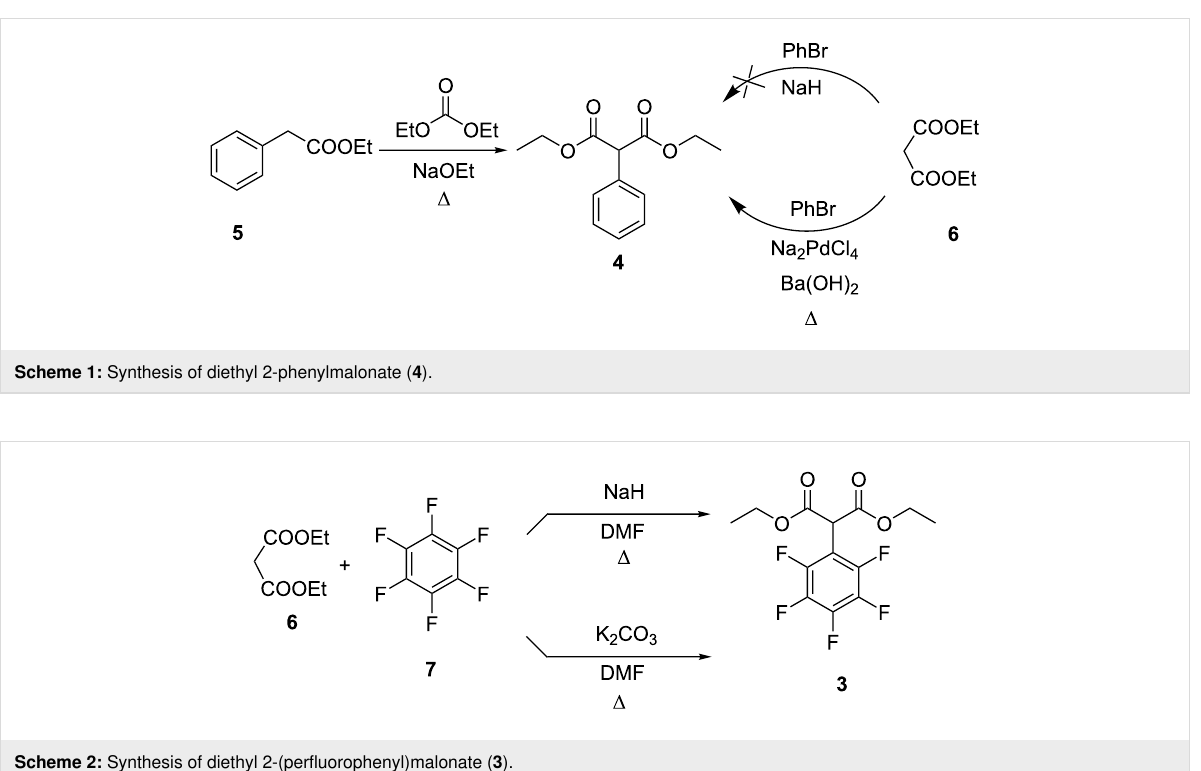
diethyl 2-(perfluorophenyl)malonate ( 3 ) with excess NaH [21]. At the same time, diethyl 2-(perfluorophenyl)malonate ( 3 ) is a readily accessible compound. Diethyl 2-phenylmalonate ( 4 ) is usually obtained (Scheme 1) by condensation of ethyl phenyl- acetate ( 5 ) and diethyl carbonate under basic conditions [22] because of the low reactivity of bromobenzene in noncatalytic nucleophilic reactions with sodium salts of diethyl malonate ( 6 )